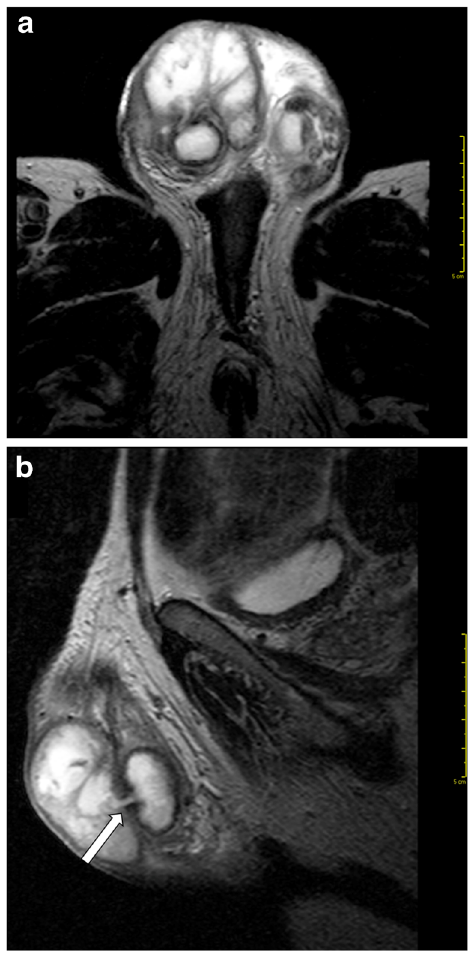
Fig. 3 a - b Intrascrotal abscess. a T2-weighted TSE sequence, axial view, and b T2-weighted TSE sequence, sagittal view, showing fistulous track (arrow)